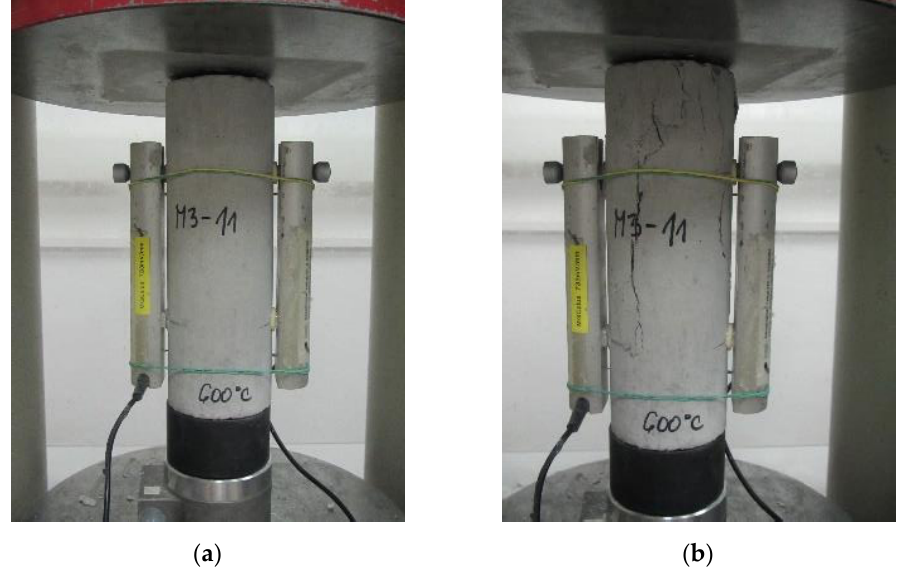
Figure 5. Appearance of the tested specimens ( a ) prior and ( b ) after mechanical loading.